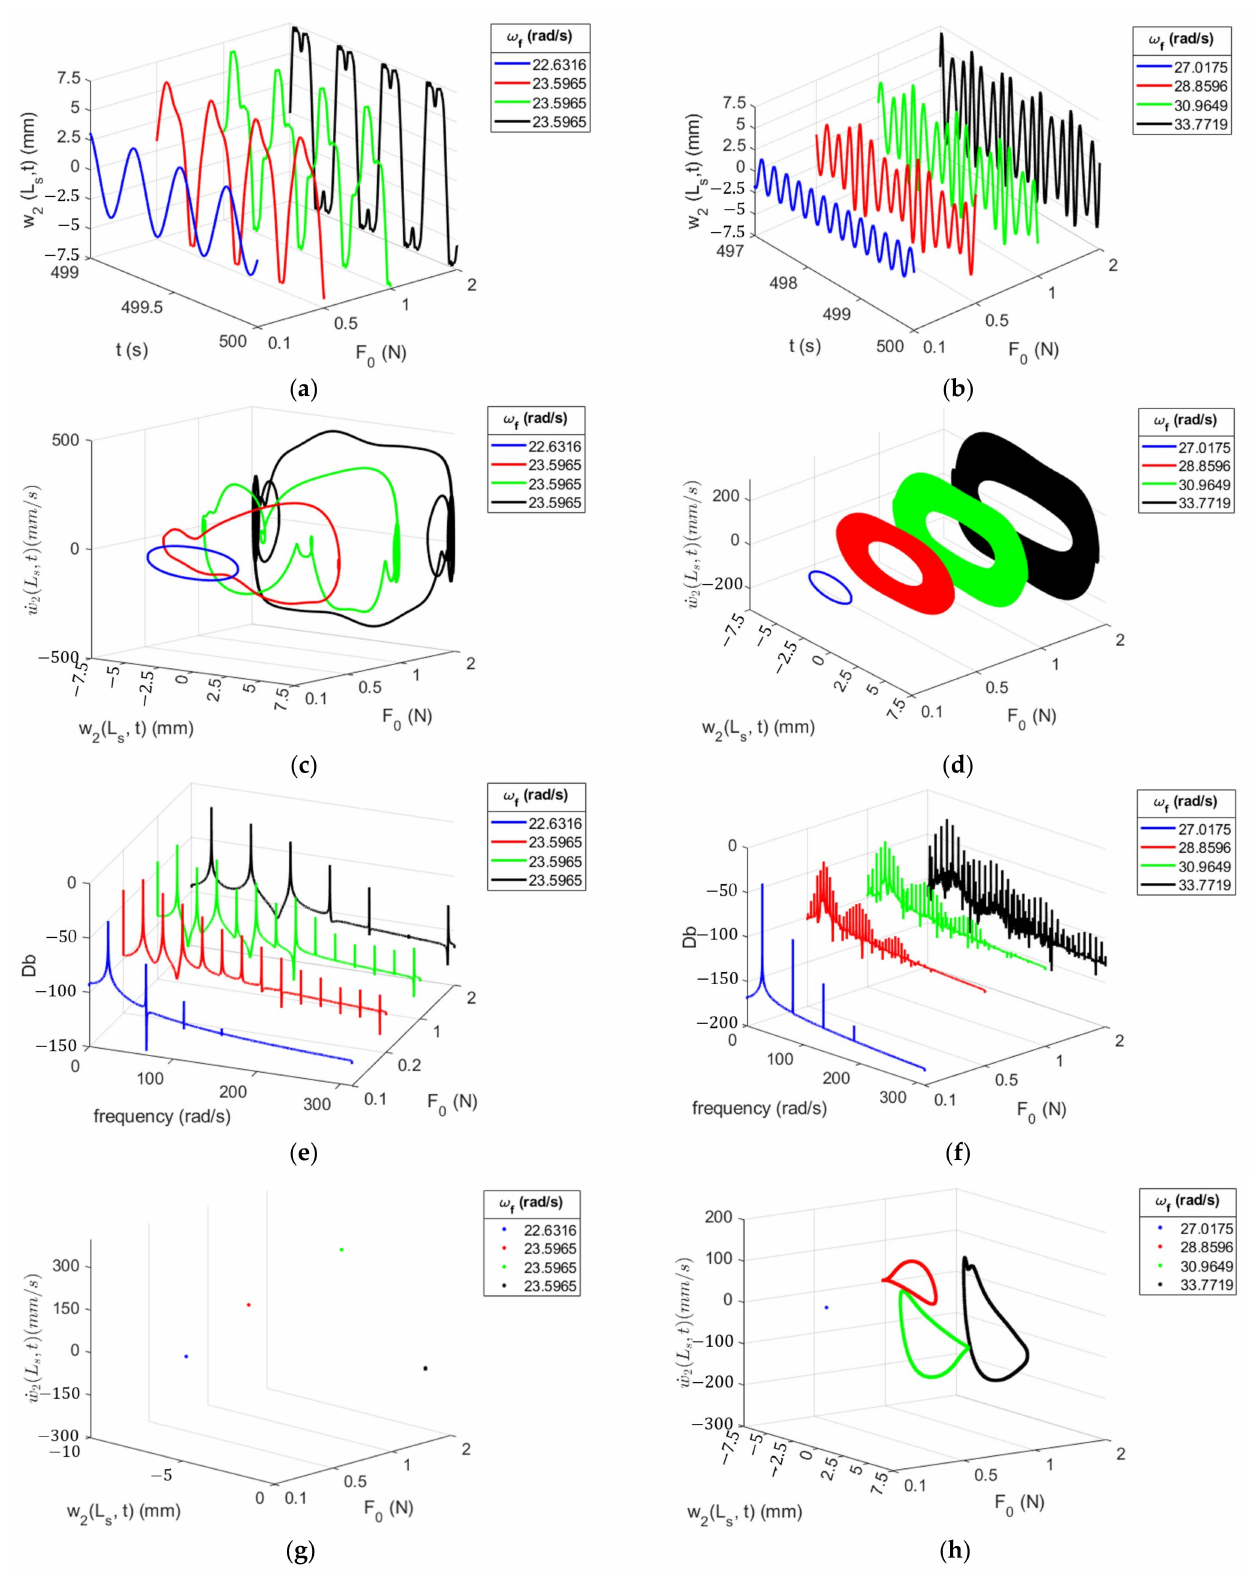
Figure A7. Nonlinear characterization of the absorber’s first (first column) and second peaks (sec- ond column) utilizing time histories ( a , b ), phase portraits ( c , d ), power spectra ( e , f ) and Poincare maps ( g , h